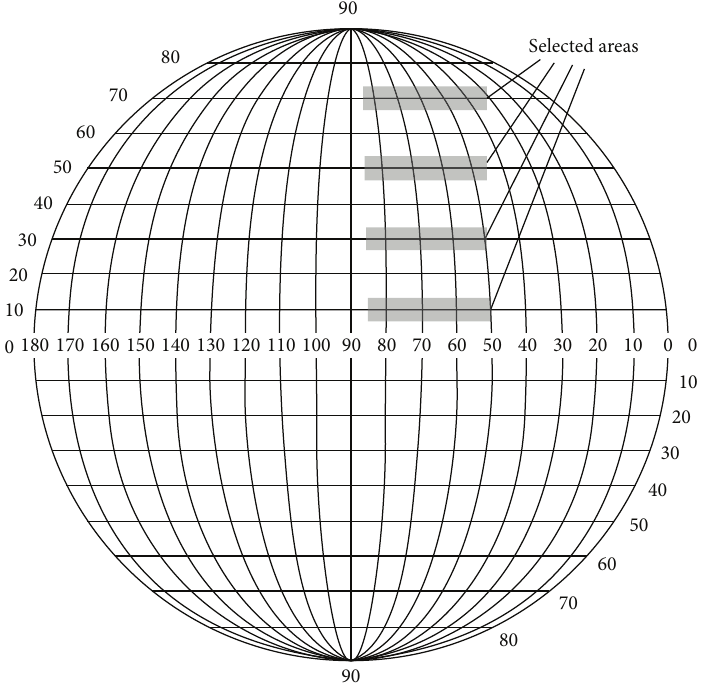
Figure 7: Samples of the selected